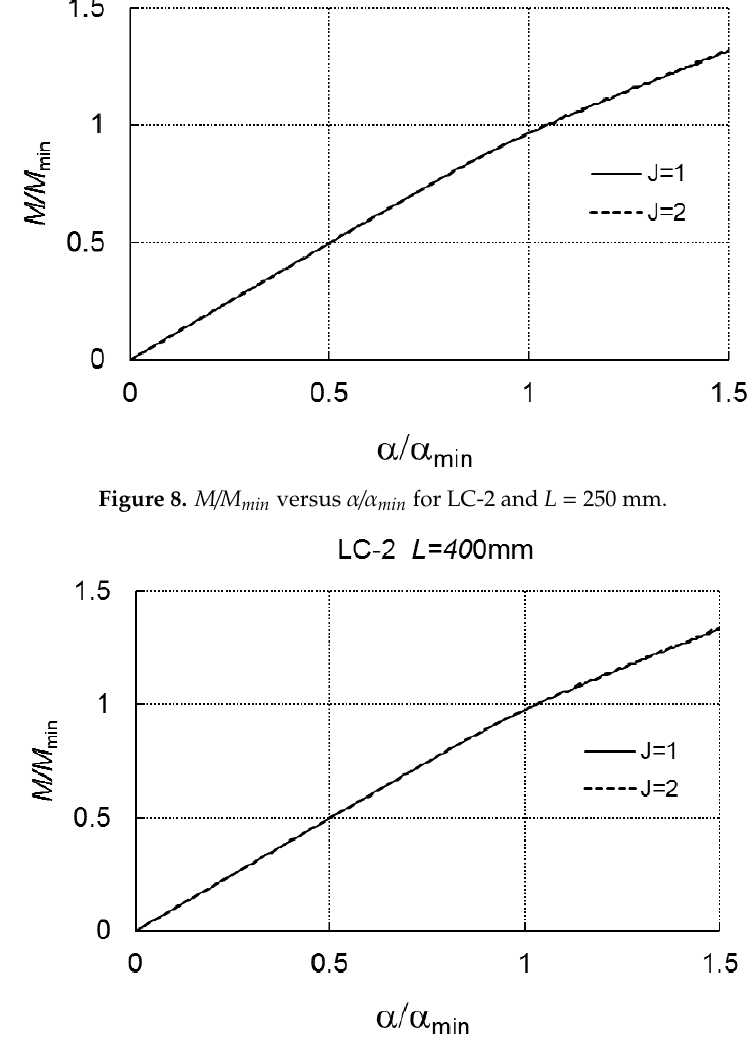
Figure 9. M / M min versus α / α min for LC-2 and L = 400 Figure 9 . M/M m in versus α / α min for LC-2 and L = 400 mm. Figure 9 . M/M m in versus α / α min for LC-2 and L = 400 mm.